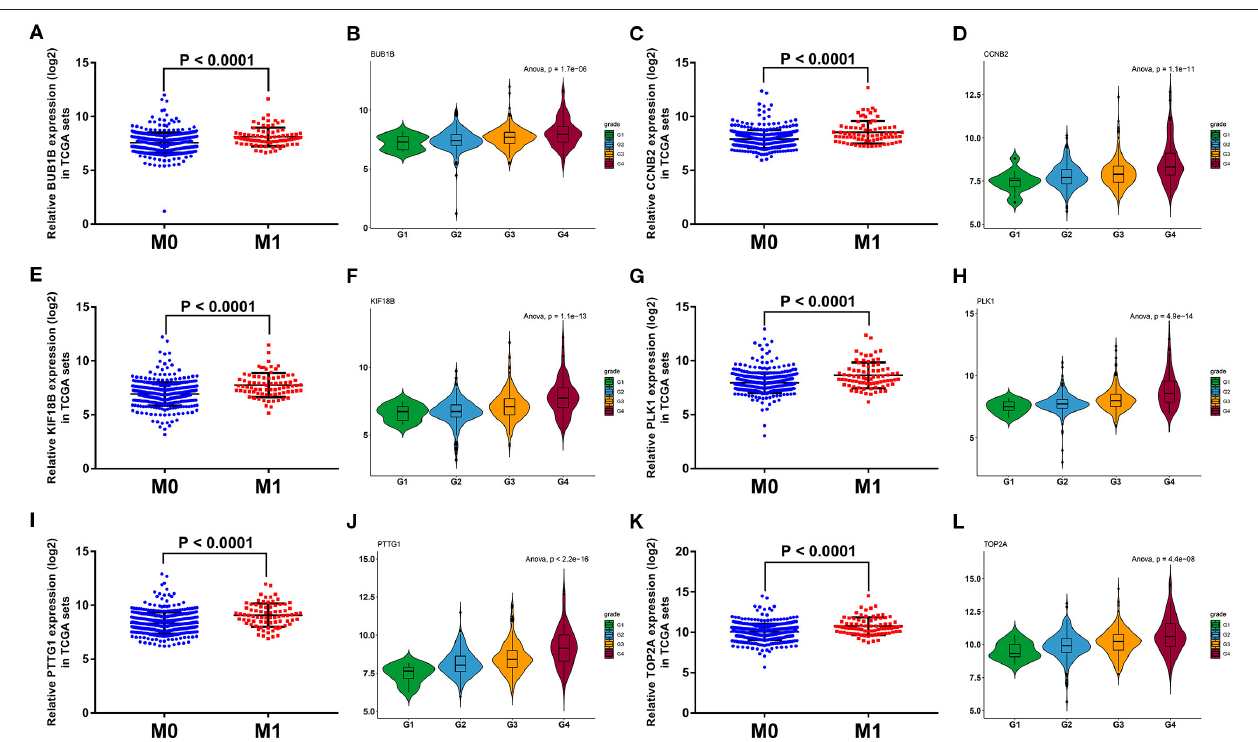
FIGURE 5 | Grade and distant metastasis expression analyses of six hub mRNAs in the TCGA database. Expression analyses of BUB1B (A) , CCNB2 (C) , KIF18B (E) , PLK1 (G) , PTTG1 (I) , TOP2A (K) between distant metastasis samples (M1) and non-distant metastasis samples (M0). Expression patterns of BUB1B (B) , CCNB2 (D) , KIF18B (F) , PLK1 (H) , PTTG1 (J) , TOP2A (L) in different grades. The value of p < 0.05 iss considered statistically significant. TCGA, the cancer genome atlas; mRNAs, messenger